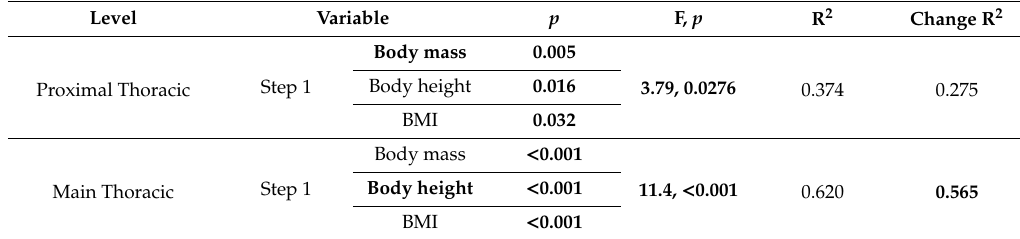
Table 3. The regression analysis predicting the mean of ATR value in girls aged 12 years ( n = 499). Level Variable